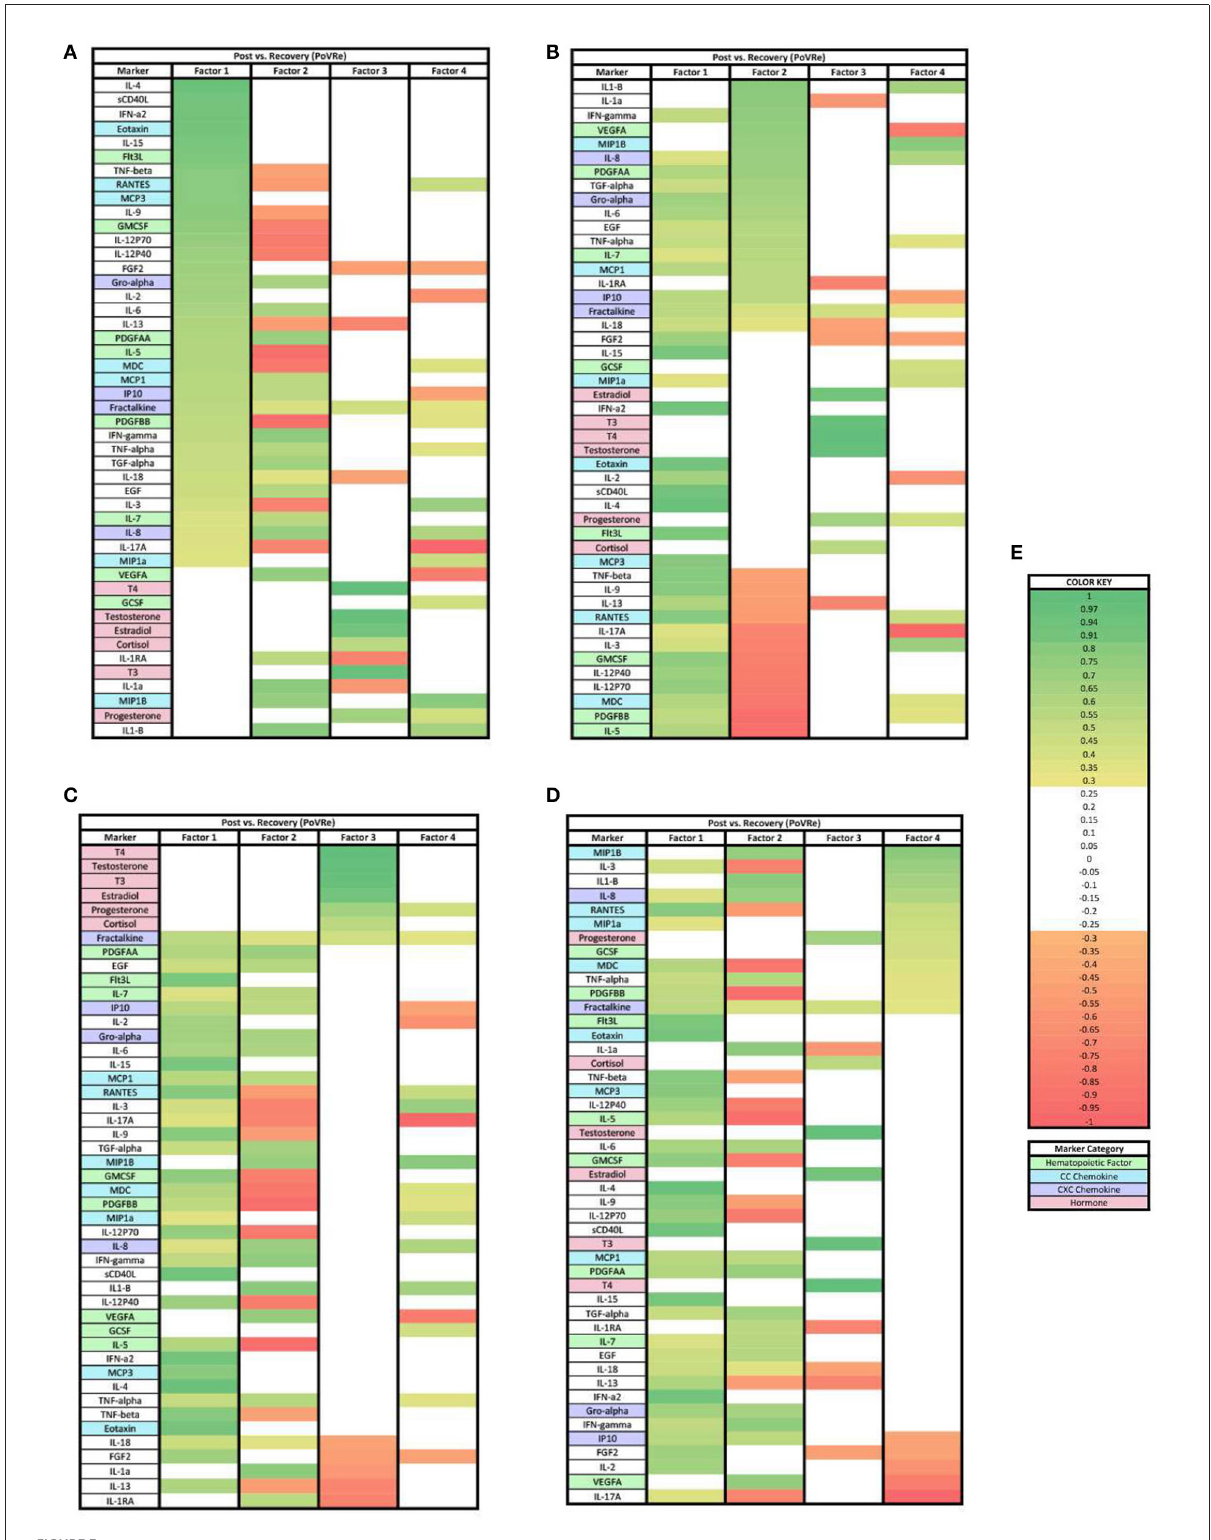
FIGURE3 Heat maps of the post-stress vs. recovery (PoVRe) analysis of loadings ≥ 0.3. (A) Biomarkers sorted from highest to lowest loading in PoVRe factor 1. (B) Biomarkers sorted from highest to lowest loading in PoVRe factor 2. (C) Biomarkers sorted from highest to lowest loading in PoVRe factor 3. (D) Biomarkers sorted from highest to lowest loading in PoVRe factor 4. (E) Color key for PoVRe loadings ≥ 0.3, sorted top to bottom from most positive to most